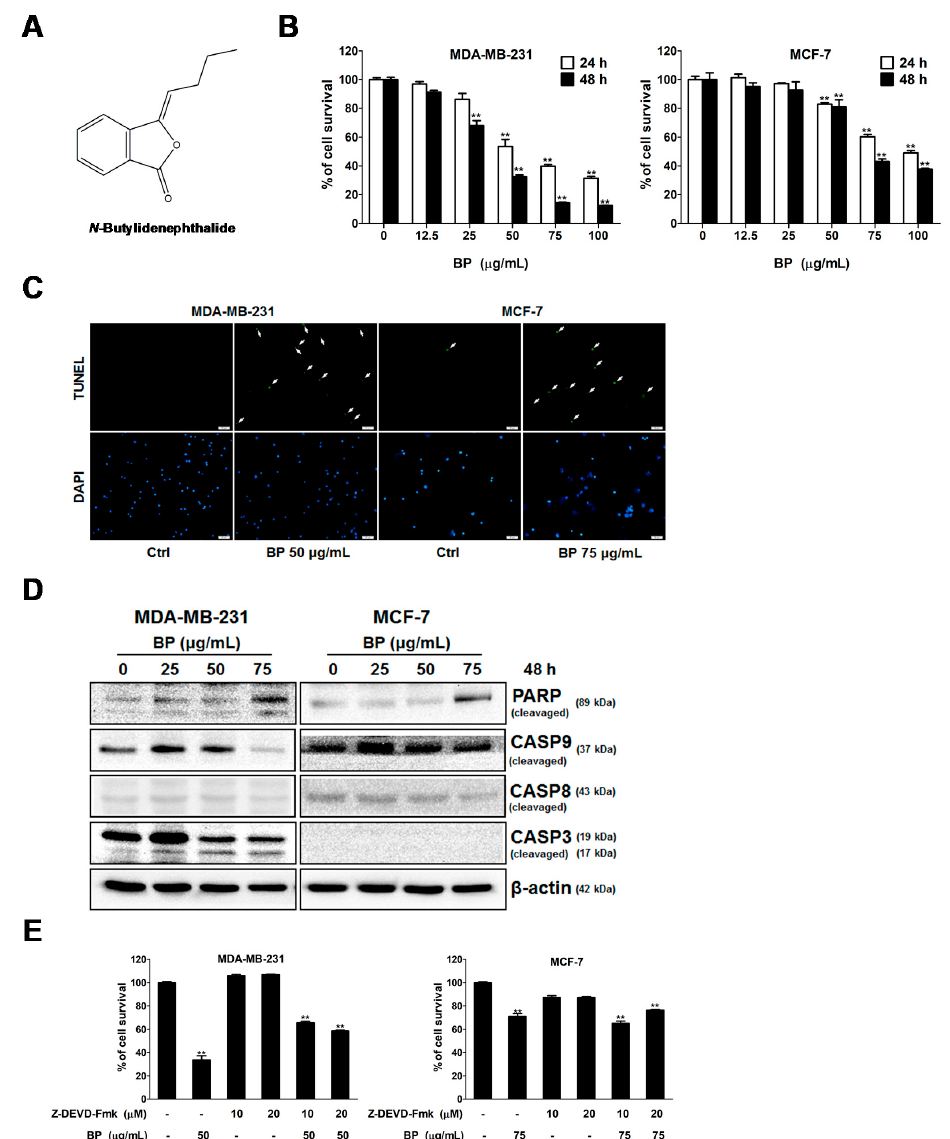
Figure 1. Effects of BP on the viability of human breast cancer cells. ( A ) Molecular structure of BP, C 12 H 12 O 2 , MW: 188.23; ( B ) Human breast cancer cells were treated with 0.2% DMSO as vehicle control or increasing concentration of BP (12.5 to 100 μ g/mL) for 24 ( □ ) and 48 h ( ■ ), respectively, and the survival rate was evaluated with the MTT assay; ( C ) Human breast cancer cells were treated in the presence or absence of BP for 48 h and then were fixed and stained with the TUNEL assay. Nuclei were stained with DAPI. TUNEL positive cells are indicated by arrows. Scale bar: 50 μ m; Panel ( D ) Human breast cancer cells were treated with 25, 50 and 75 μ g/mL BP for 48 h, and Western blot analysis was performed for cleaved PARP, caspase-9, caspase-8, and caspase-3. β -actin was used as an internal control; ( E ) Human breast cancer cells pretreated with caspase-3 inhibitor Z-DEVD-fmk (10 or 20 μ M) for 1 h and then treated in the presence or absence of BP for 48 h, the survival rate was evaluated with the MTT assay. Data are presented as means ± S.D. obtained from three different experiments. ** p < 0.01 vs. vehicle.